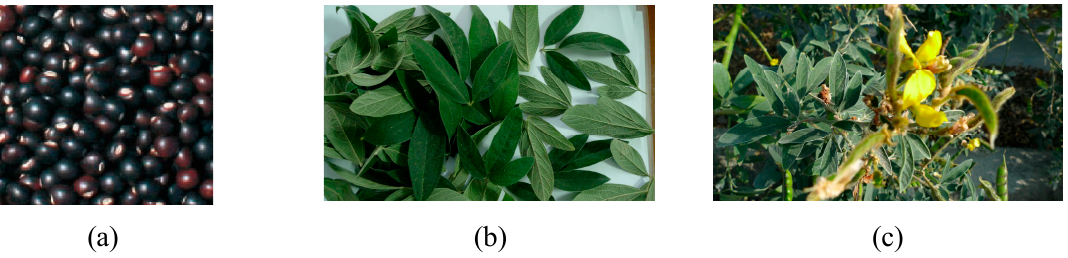
Figure 8. Representative Cajanus cajan (L.) Millsp. plants cultivar Taitung No. 3; ( a ) mature pea; ( b ) sample leaves; and ( c ) the early pod bearing stage harvest on 121 days after